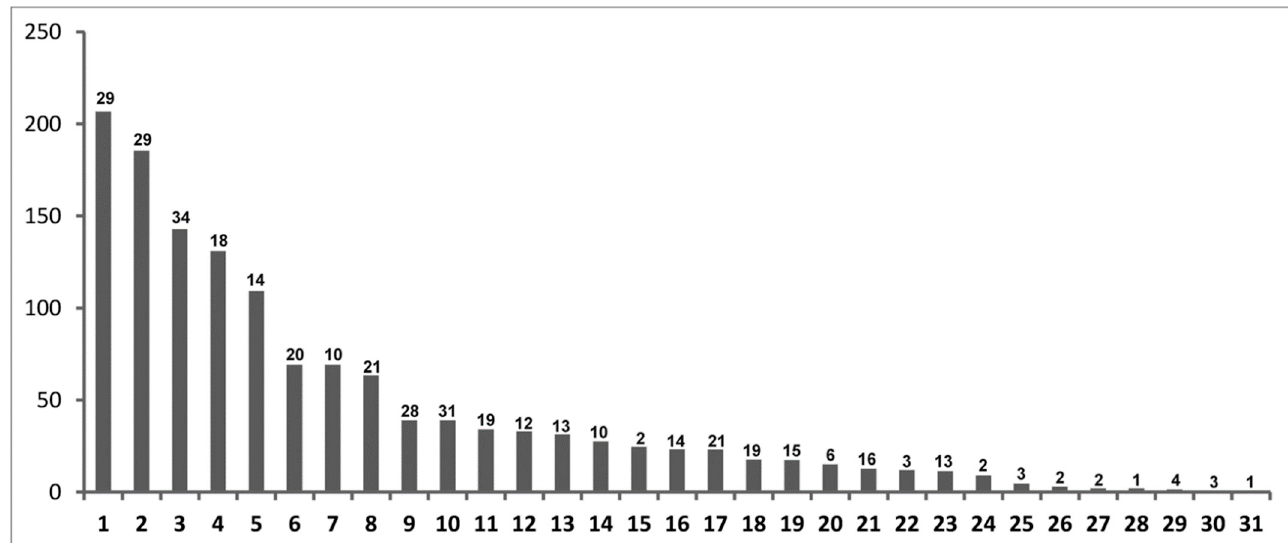
Figure 4. Relative abundance for examined tree species allow to discern six groups with different impact on abundance of Uropodina mites in forest eco-systems: 1—pine, 2—oak, 3—beech, 4—hornbeam, 5—larch, 6—black alder, 7—aspen,